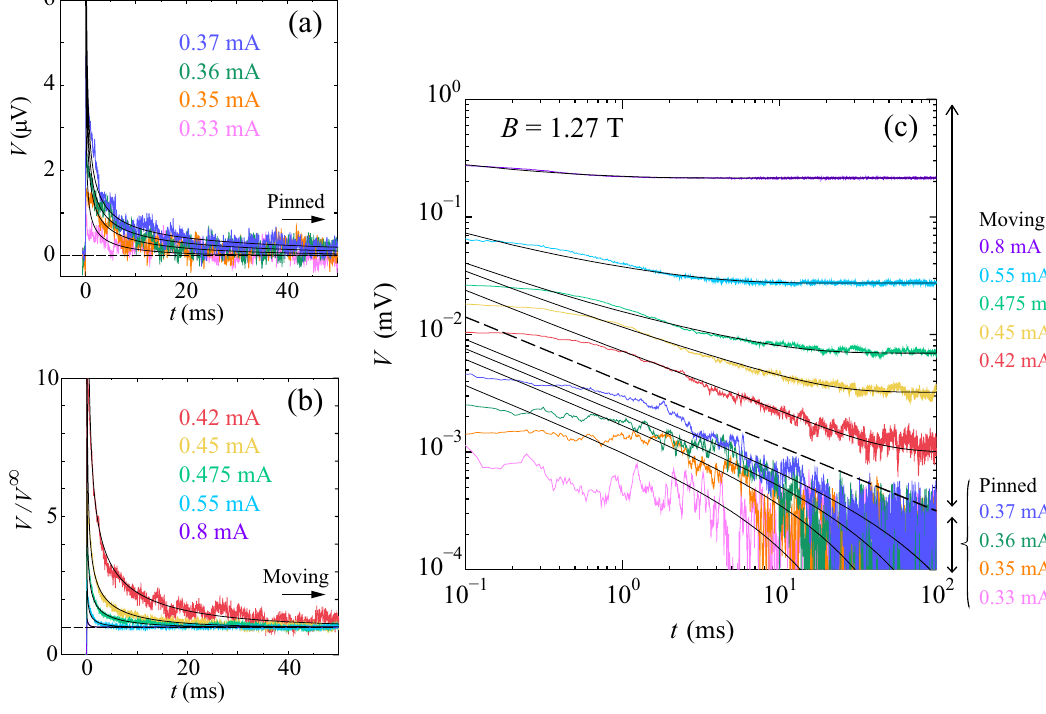
Figure 3. The dynamic disordering of vortices driven by dc currents around the depinning transition ( I c 0.375 mA). ( a ) V ( t ) and ( b ) V ( t )/ V ∞ at 4.1 K in 1.27 T just after the dc currents I below and above I d ( 0.375 mA), respectively, were suddenly applied to the initial vortex assemblies at t 0.36, and 0.37 mA from bottom to top and ( b ) I Horizontal dashed lines in ( a ) and ( b ) mark the steady-state values of V ( t ) 1 (moving phase), respectively. ( c ) Replots of the data shown in ( a ) and ( b ) as log V versus log t : I 0.35, 0.36, 0.37, 0.42, 0.45, 0.475, 0.55, and 0.8 mA from bottom to top. The dashed line represents the slope of a 0.55 0.1 , within errors, nearly consistent with the theoretical value of a − = − ± class in 2D or a 0.5 for the conserved DP universality class in 2D 36,37 . Full lines in ( a – c ) indicate the fits to Eq. ≈